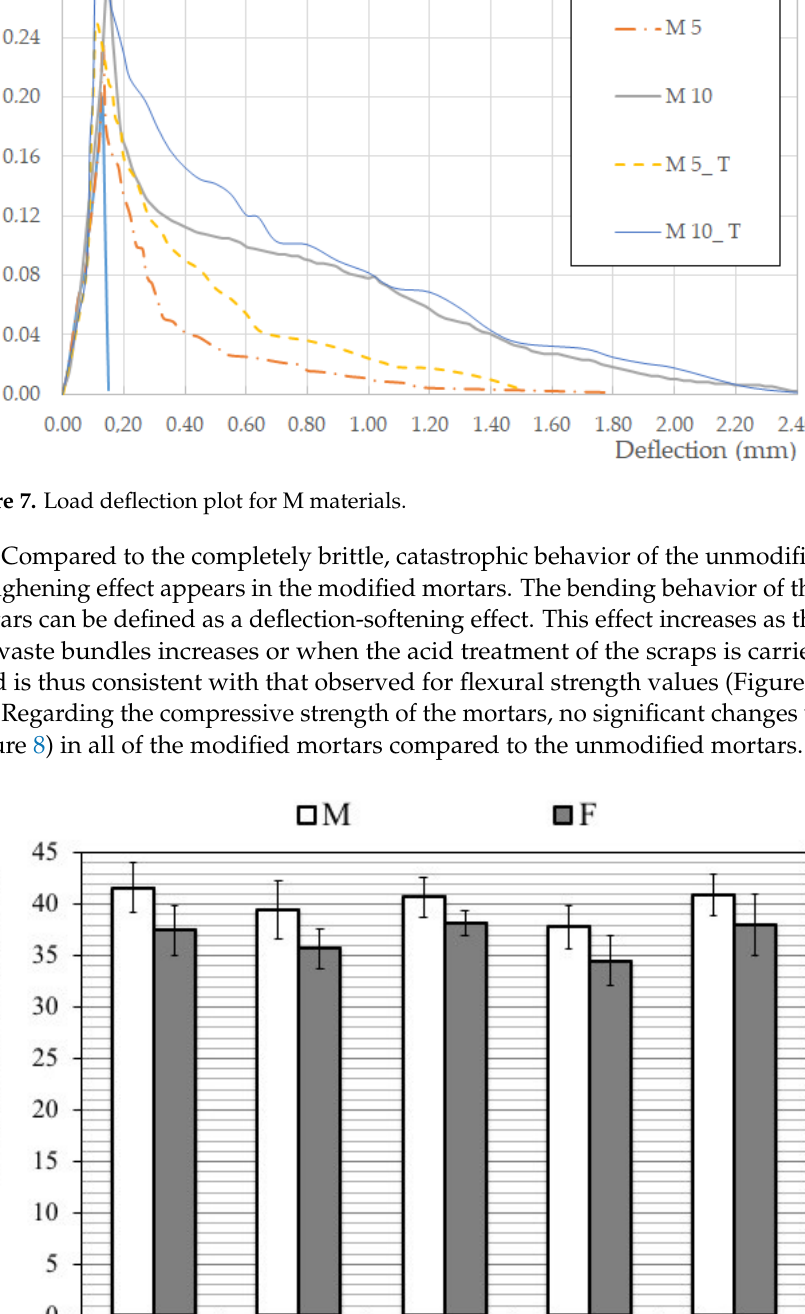
Figure 7. Load deflection plot for M materials.